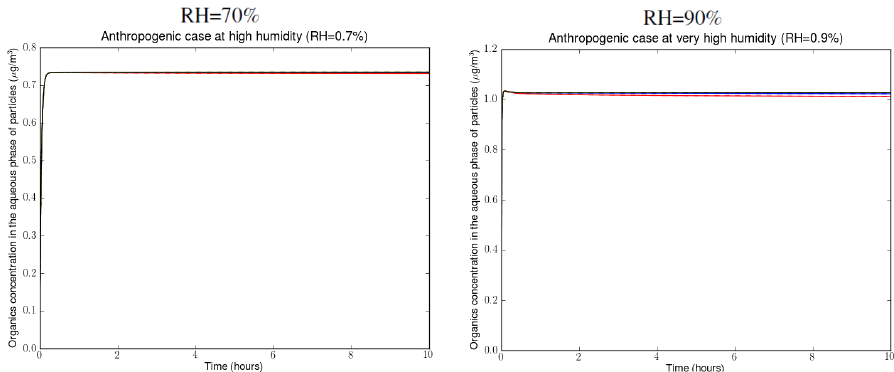
Figure 11. Evolution of concentrations in the aqueous phase for the anthropogenic case at various humidities, with initial concentrations equal to one tenth of the concentrations at equilibrium and 5µgm − 3 of non-volatile compounds for N layer = 5 (plain lines) and N layer =4 (dashed lines) for several organic-phase diffusivity: D org = 10 − 19 m 2 s − 1 (red), D org = 10 − 20 m 2 s − 1 (blue), D org = 10 − 21 m 2 s − 1